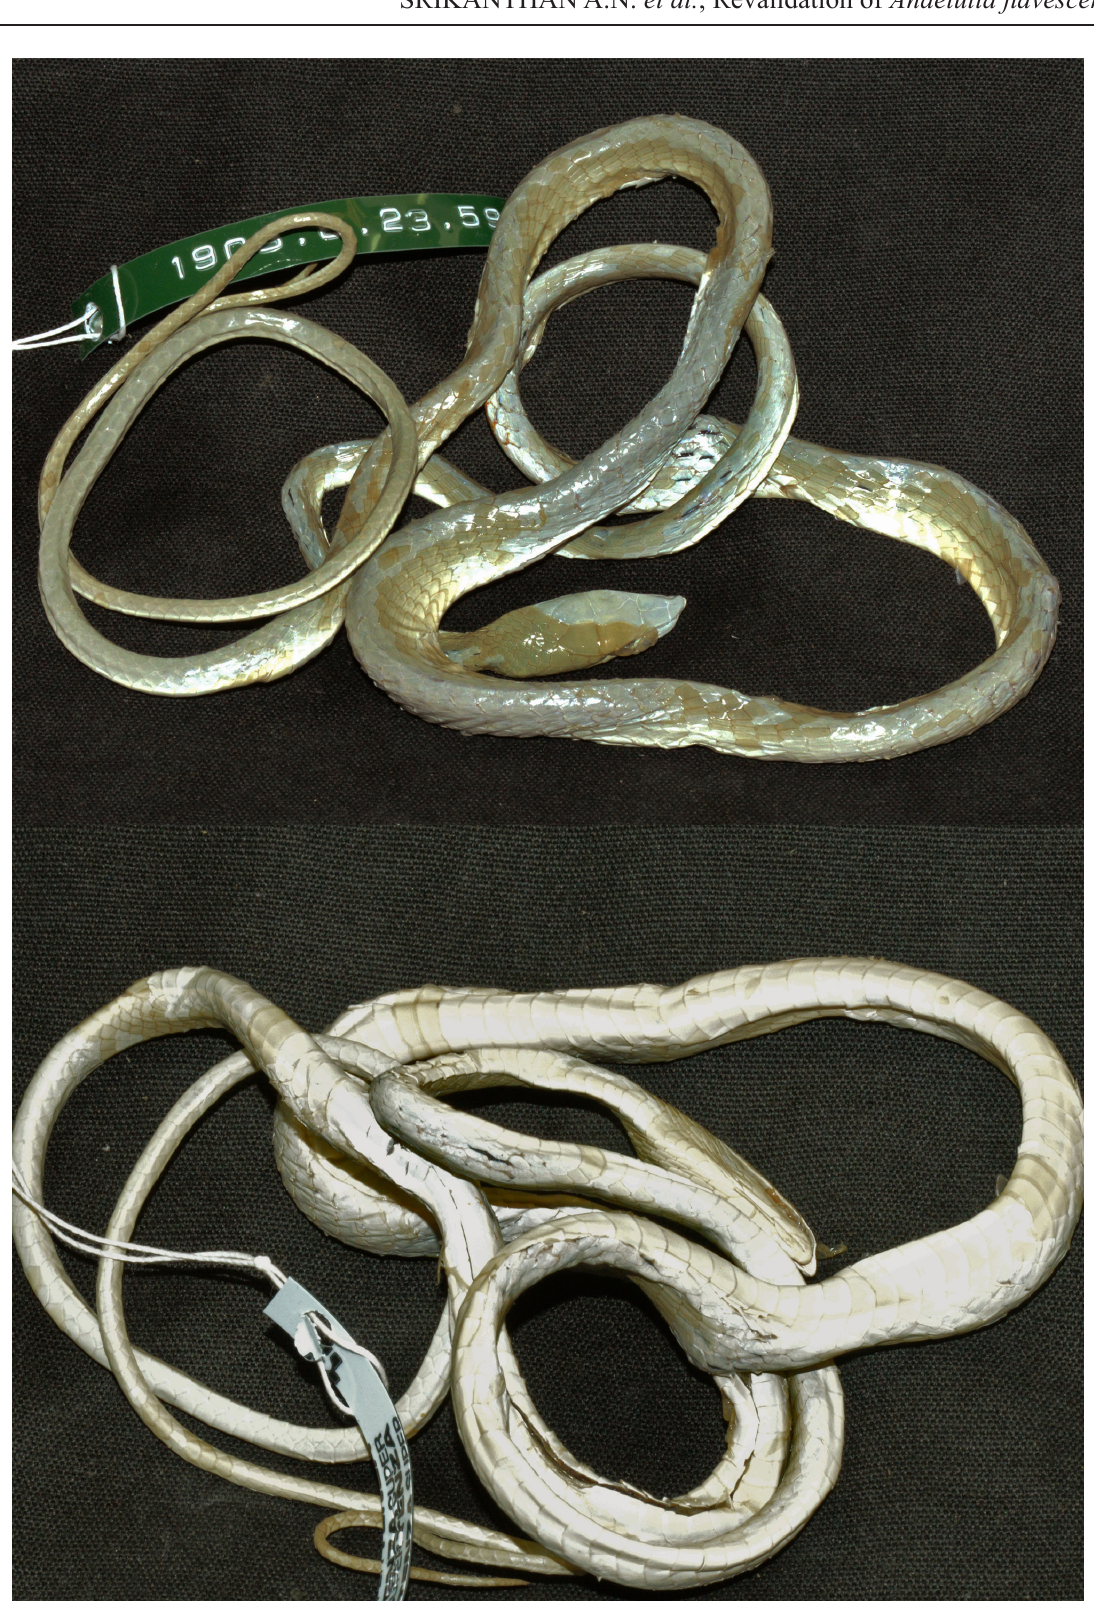
Fig. 4. Dryophis prasinus var . flavescens Wall, 1910, paralectotype (NHMUK 1908.6.23.59). Entire profile, dorsal and ventral views. Photo: © The Trustees of the Natural History Museum,